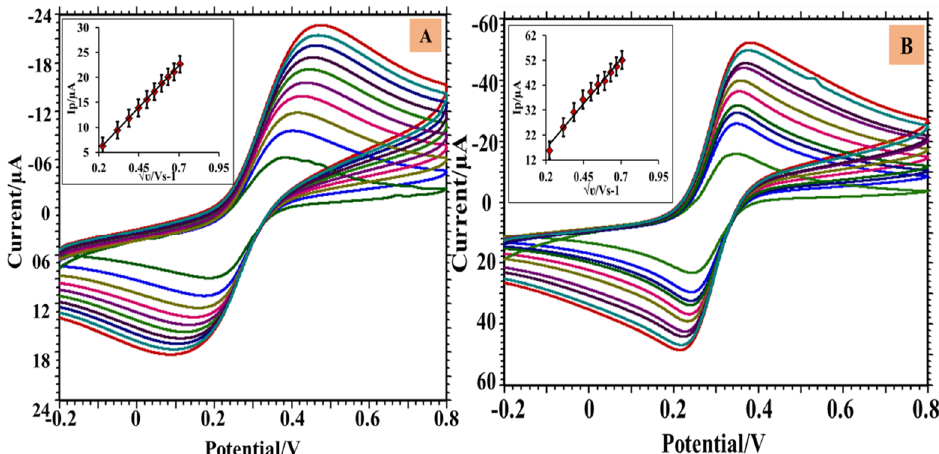
Figure 1. Cyclic voltammogram of K 3 [Fe(CN) 6 ] (1.0 mM) at different scan rates from 0.05 to 0.5 Vs − 1 . ( A ) At bare CPE. ( B ) At CuO-GO/CPE.